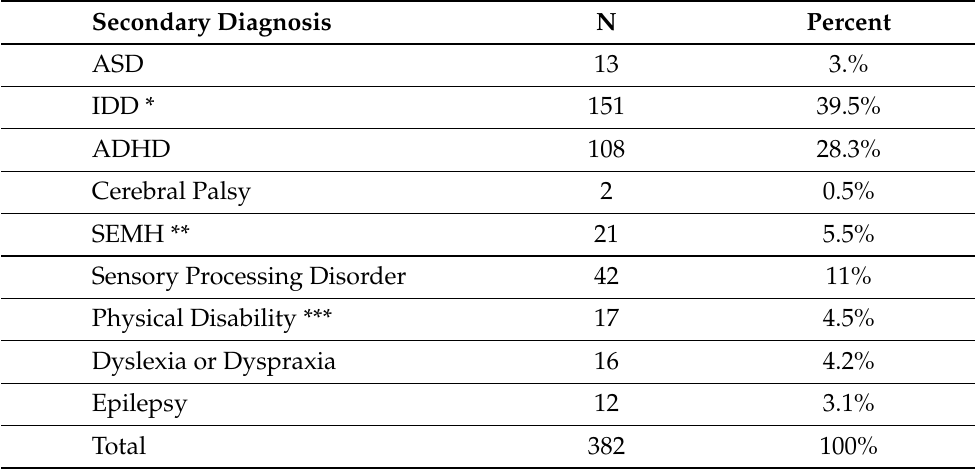
Table 2. Secondary Diagnosis and Conditions of